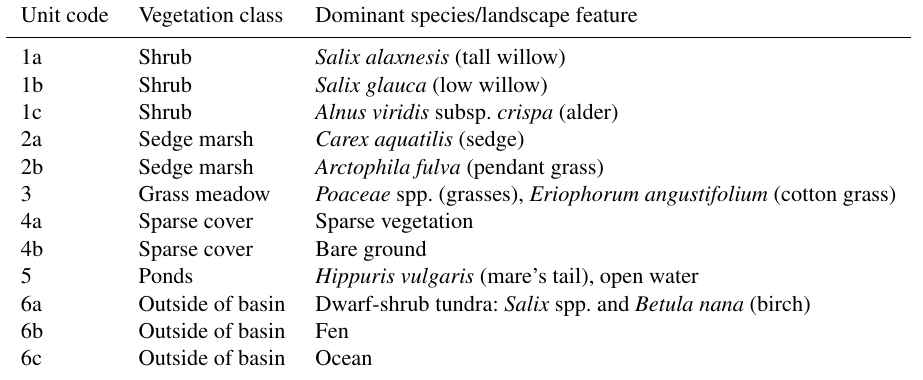
Table 1. Dominant species or landscape feature within the vegetation/cover classes. Unit codes correspond to the map in Fig. 1a. Unit